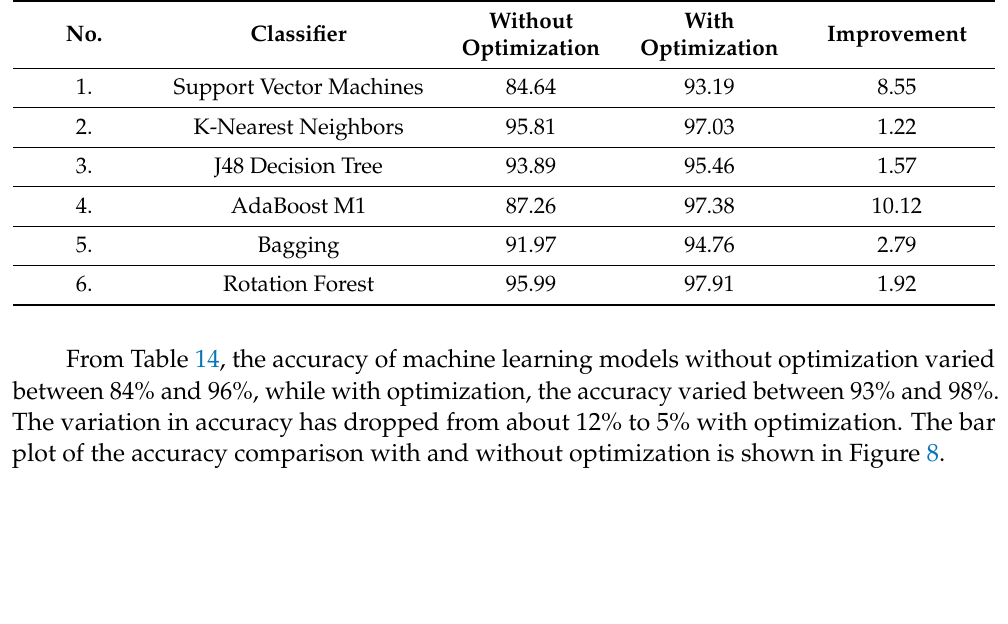
Table 14. Accuracy comparison of machine learning models without and with